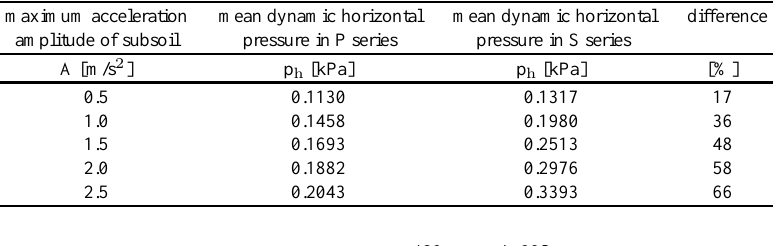
Table 3 Effect of subsoil stiffness on dynamic pressure